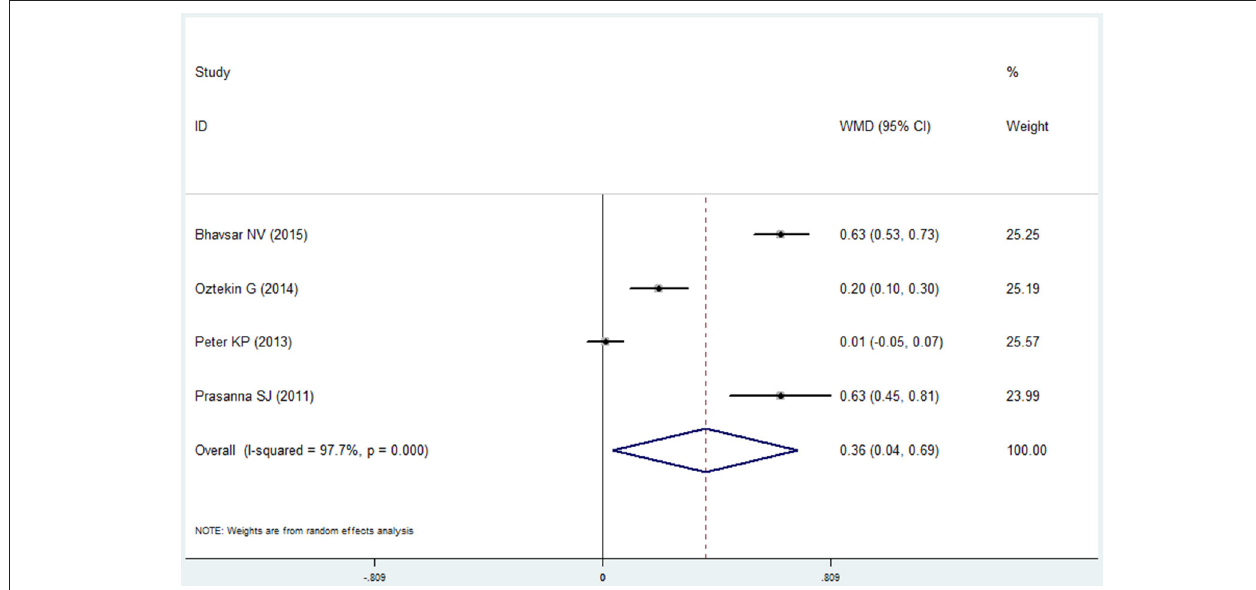
FIGURE 9 | Forest plot of the mean difference in gingival index between the COPD and non-COPD groups.